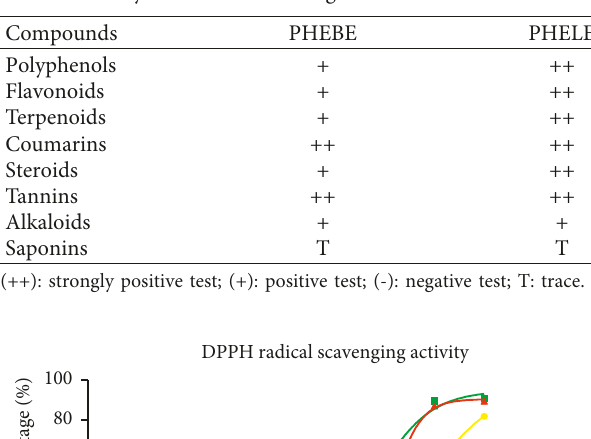
Table 1: Phytochemical screening of P. densinervia extracts.